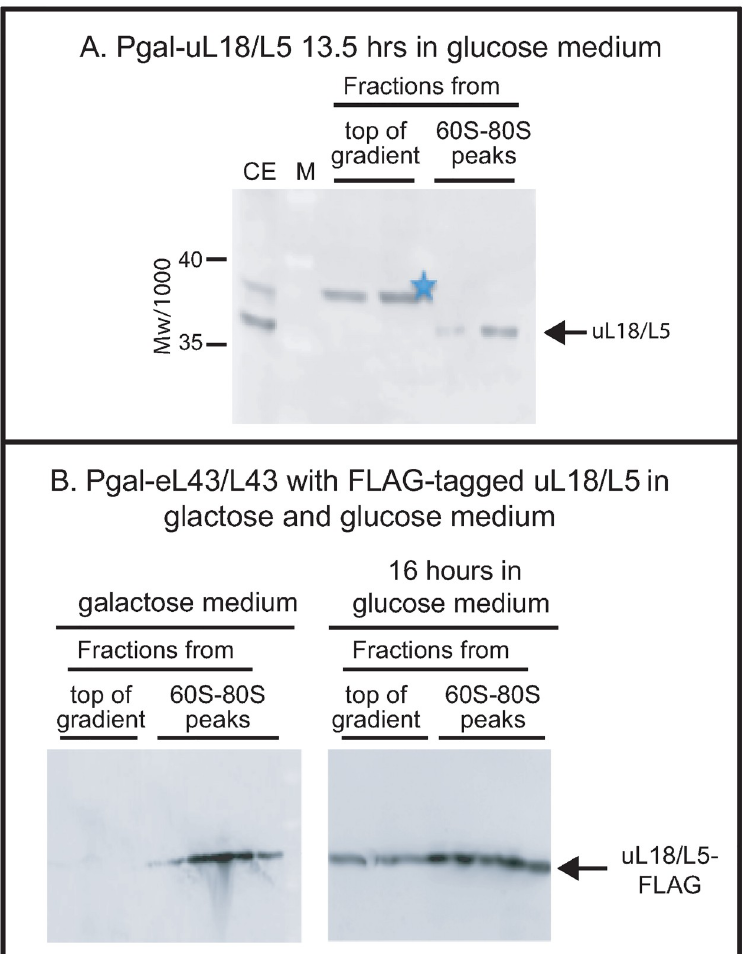
Fig 1. Analysis of the specificity of anti-uL18/L5. (A) The uL18/L5 reactive band seen close to the top of the sucrose gradient after repressing eL43/L43 or eL40/L40 formation (Figs 2 and 3) is absent after repressing uL18/L5 synthesis. P gal -uL18/L5 was grown in galactose medium and shifted to glucose medium. A lysate prepared after repression of uL18/L5 gene for 13.5 hours was fractionated on a sucrose gradient and consecutive fractions from the top of the gradient and the 60S-80S ribosome peaks were analyzed by western blot stained with anti-uL18/L5. (B) Distribution of FLAG-tagged uL18/L5 (uL18/L5-FLAG) in sucrose gradients loaded with lysates prepared before and after repressing eL43/L43 synthesis. P gal -eL43/L43 was transformed with a plasmid harboring a constitutively expressed gene for uL18/ L5-FLAG. The resulting strain was grown in galactose medium and shifted to glucose medium for 16 hours. Lysates prepared from cells before and after the shift were fractionated on sucrose gradient and aliquots of consecutive fractions from the top of the gradient and the 60S-80S peaks were analyzed for content of FLAG-tagged protein by western blot. The western blots in this figure were not cropped. M: Molecular weight markers/1000. CE: Crude cell Extract.